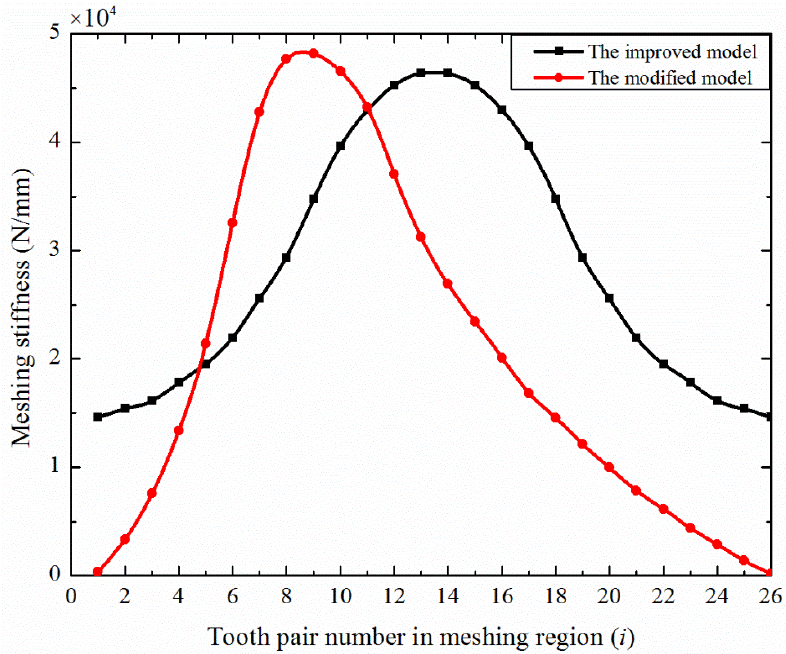
Figure 16. Meshing stiffness of the disposable HD obtained by two methods.